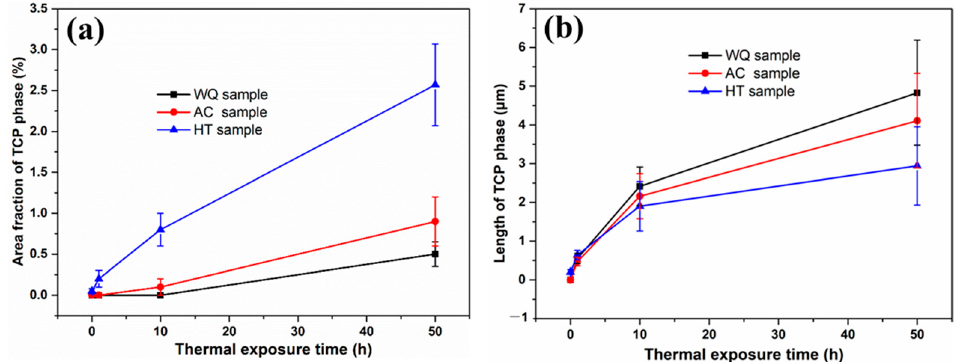
Figure 9. Typical TEM images and SAD patterns ( a ) and the compositional result by EDS ( b ) of σ phases for HT samples after thermal exposure at 1100 °C for 50 h.